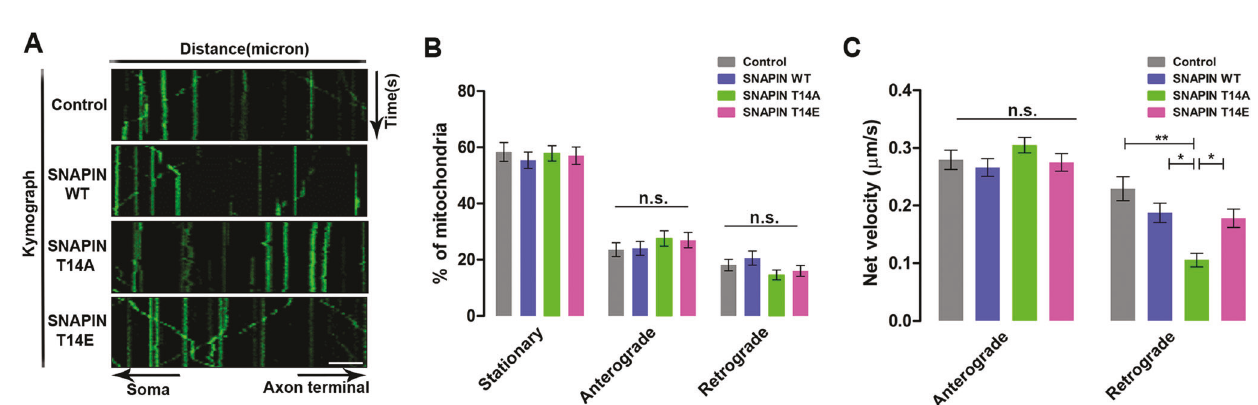
monitored by an exponential decay constant, remained unaltered in Snapin -KD neurons compared with those of control neurons, which is consistent with a previous report [25]. We further found that introducing SNAPIN-WT or SNAPIN-T14E mutant in the background of Snapin -KD fully restored the recycling pool size